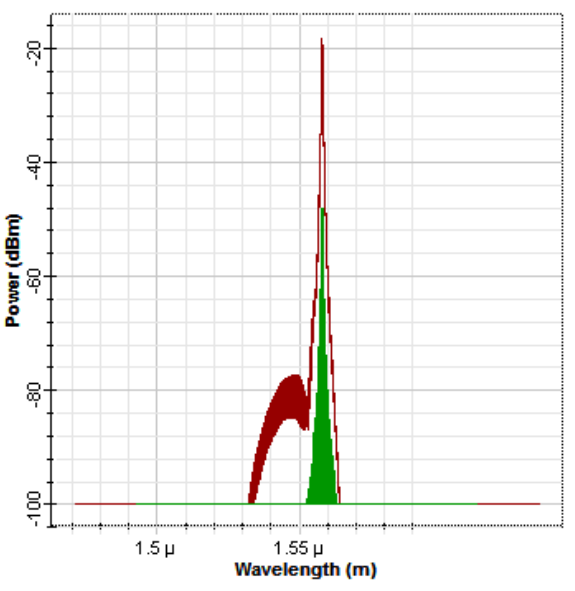
Figure 4. Output spectrum for BPF1.